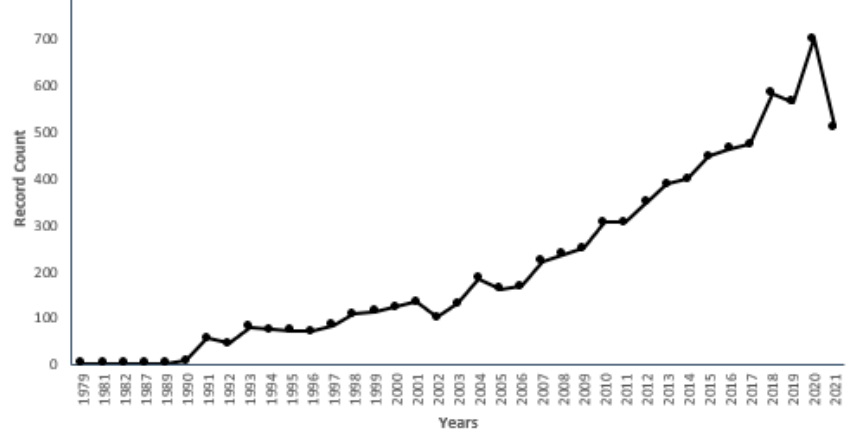
Figure 1. The annual number of publications related to the impacts of climate change on heavy metal contamination in coastal areas, based on the Web of Science Core Collection database (1979–2021).